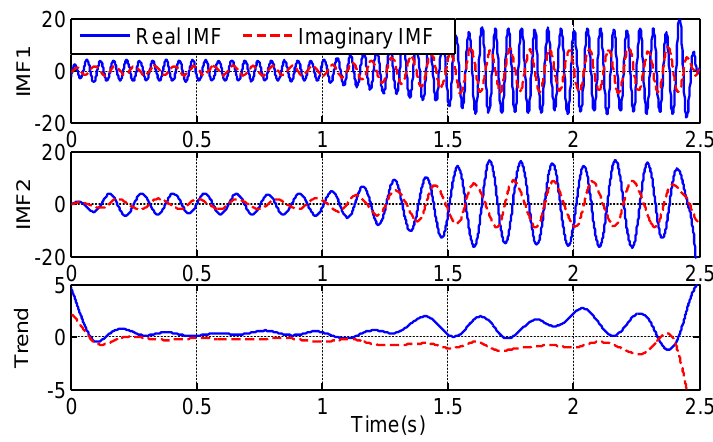
Figure 4. True IMFs of the simulated chatter signal.